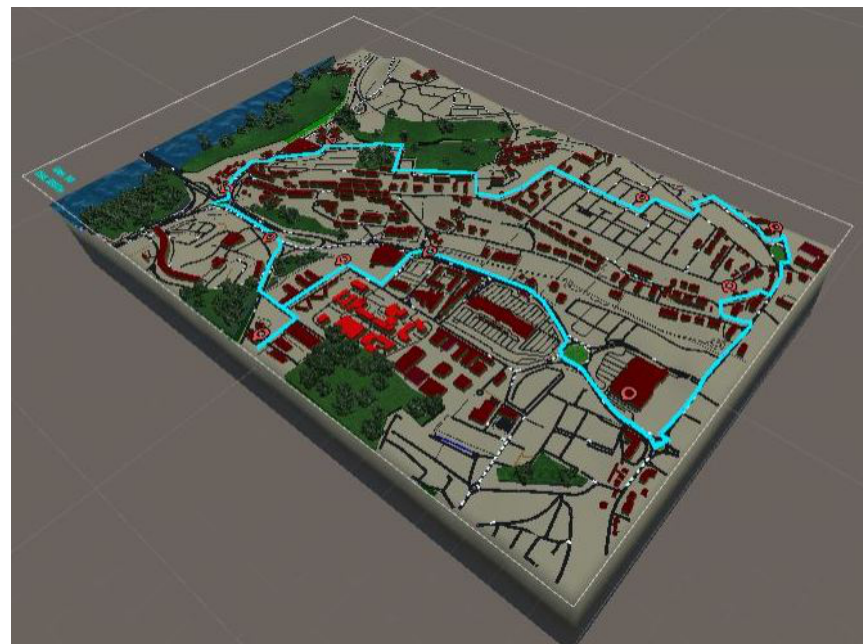
Figure 10. Example of a path planned to visit ten different points of interest, simulated in the computer. The red donuts are points of interest, the solution path is marked in